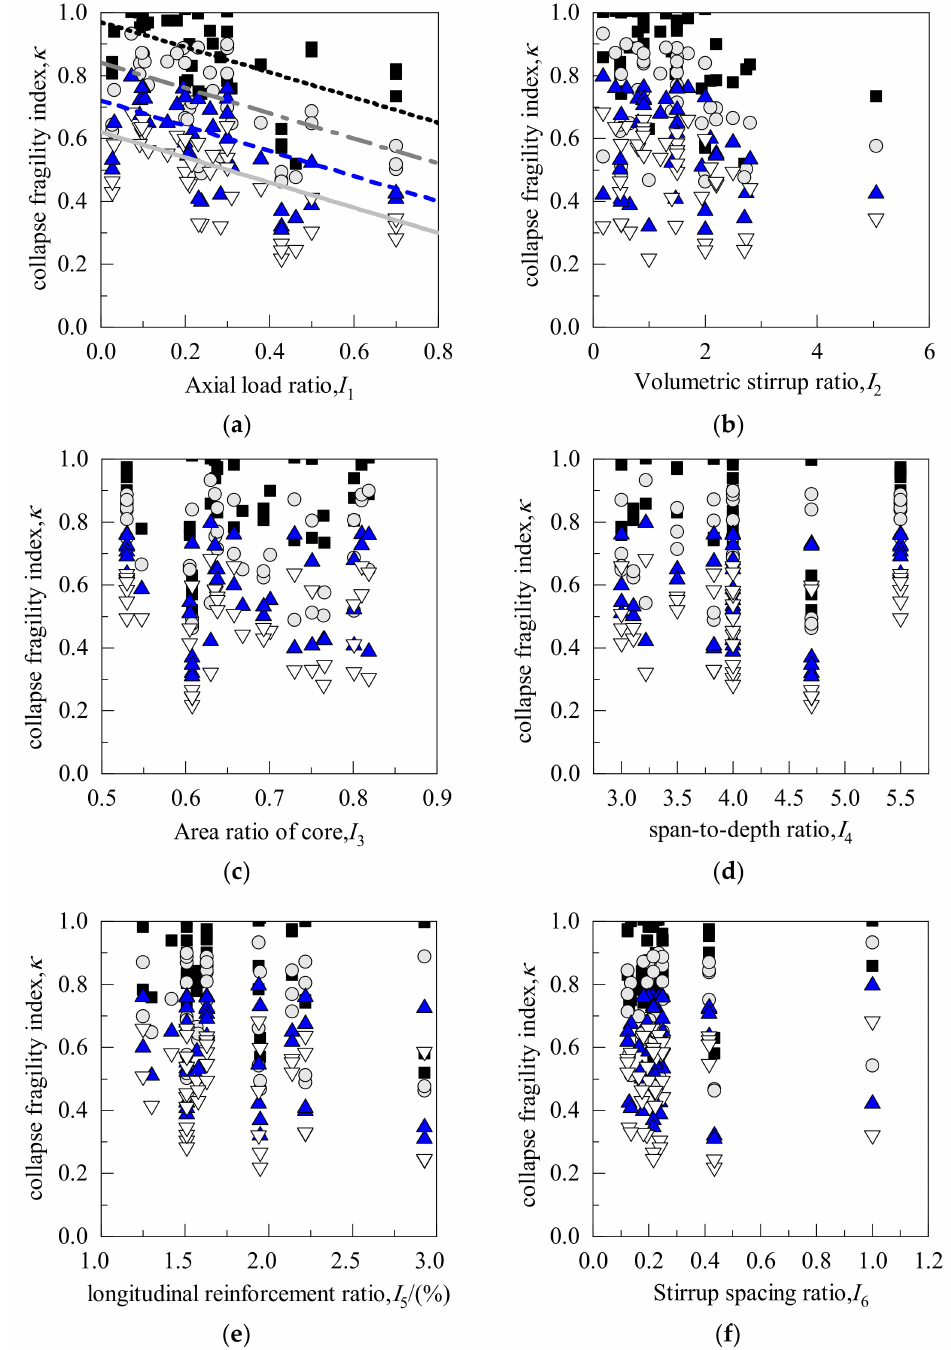
Figure 11. Distribution of collapse fragility index corresponding to each structural characteristic parameter under different damage states. (black square: slight damage state; grey circle: moderate damage state; blue triangle: severe damage state; white inverted triangle: extreme damage